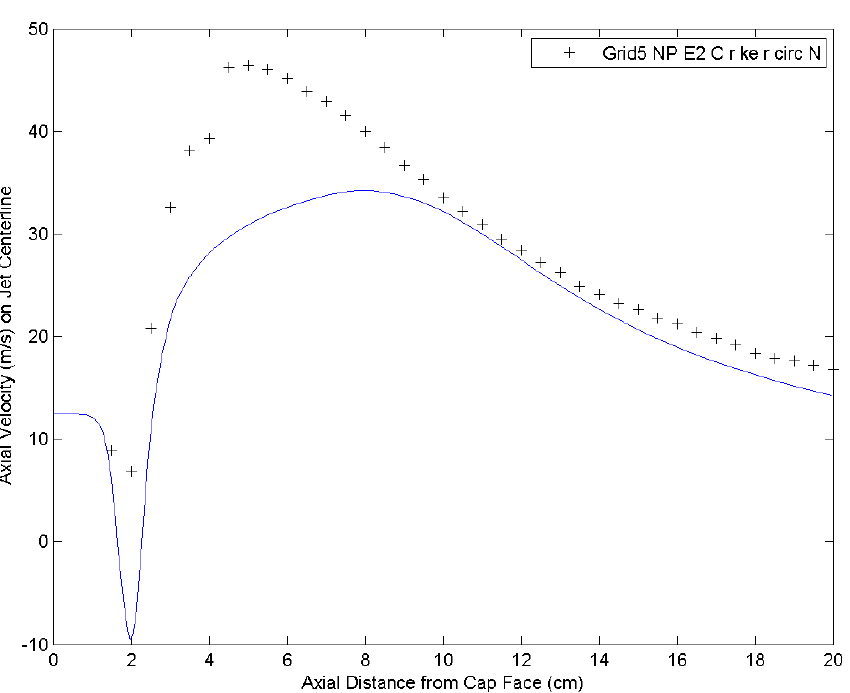
Figure 21. Experiment 2: The Centerline Velocity: Comparison of numerical (line) and experimental (crosses)